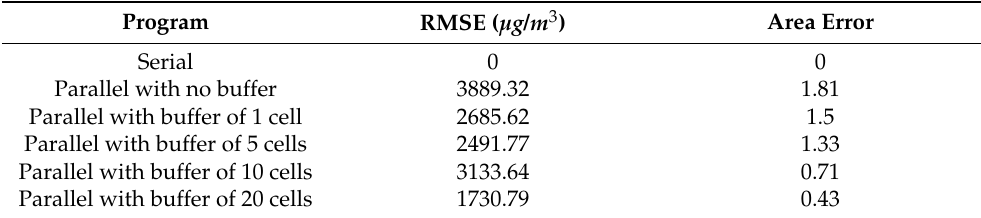
Table 4. RMSE and area error.